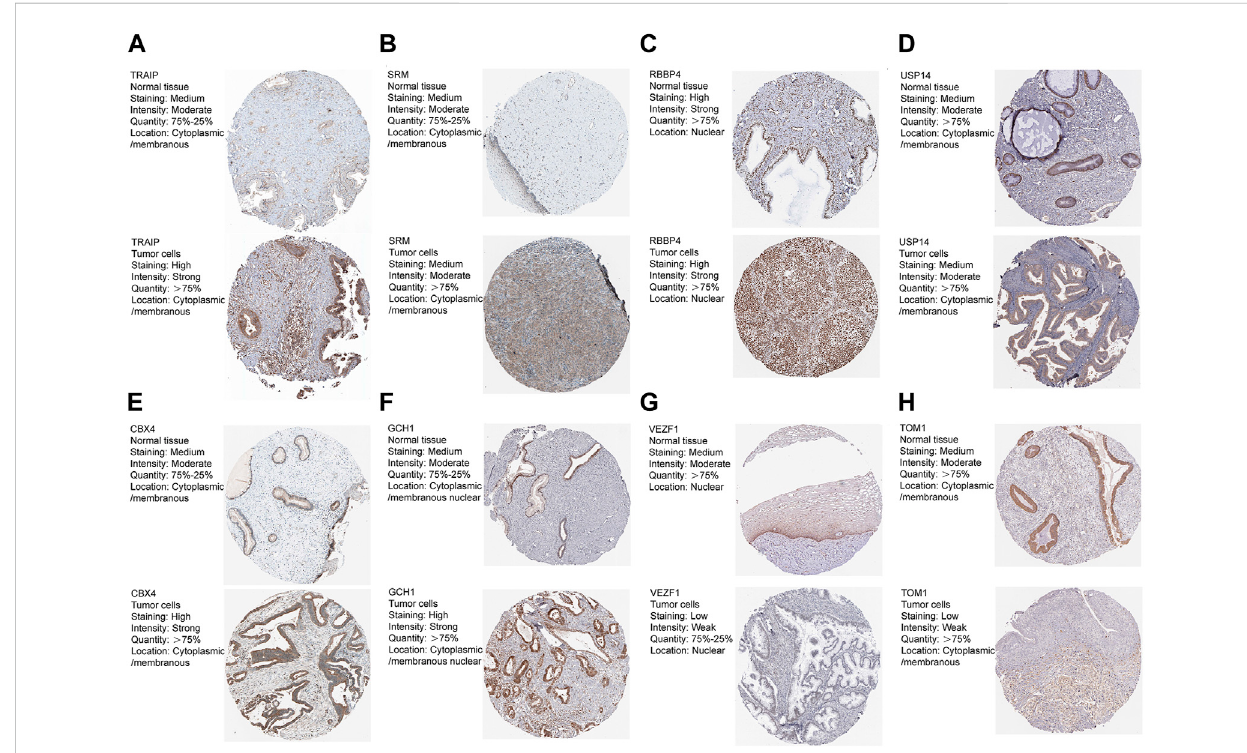
FIGURE 6 (A-H) Eight genes protein levels between normal and cancer tissues from the HPA